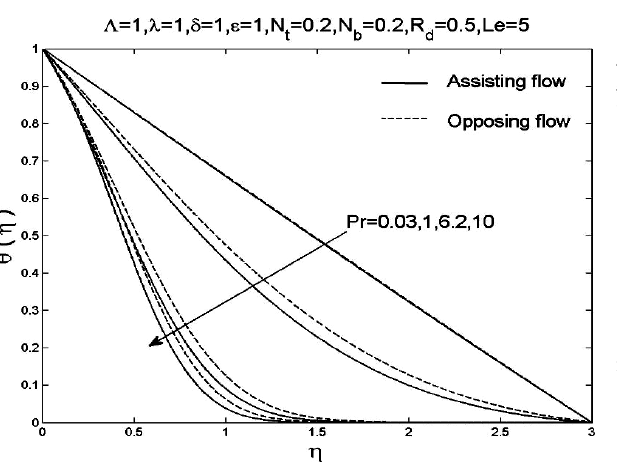
Fig. 18 . The effect of the Prandtl number Pr on the temperature profiles ( ) θη .